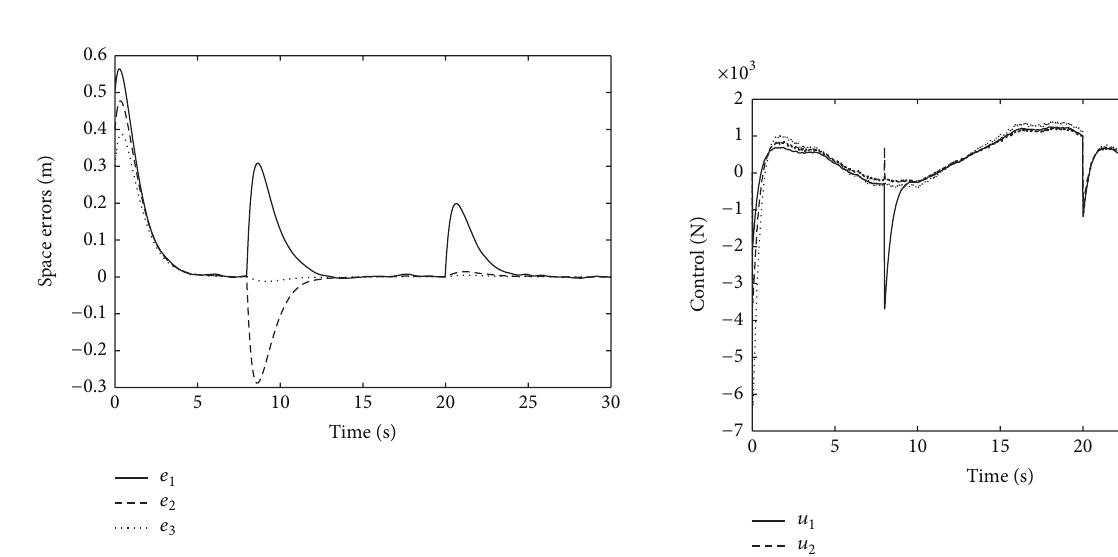
Figure 3: Spacing error curves of vehicles. Table 1: Initial states of vehicles.